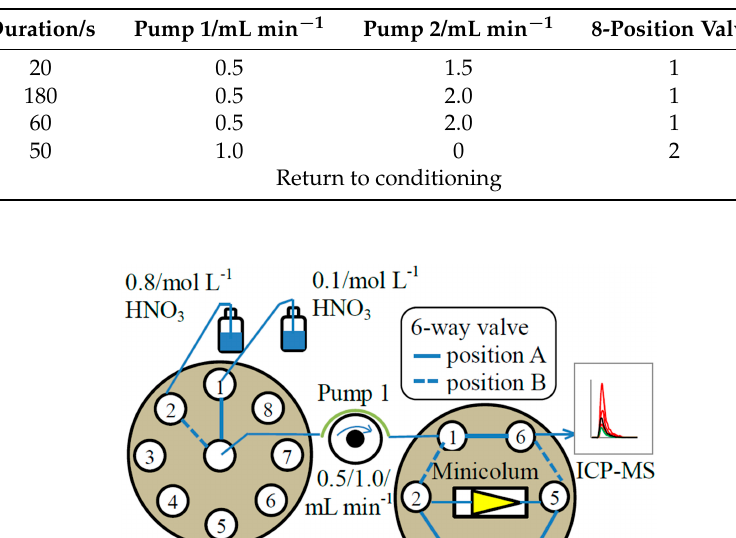
Table 5. Typical flow injection program and valve position description.